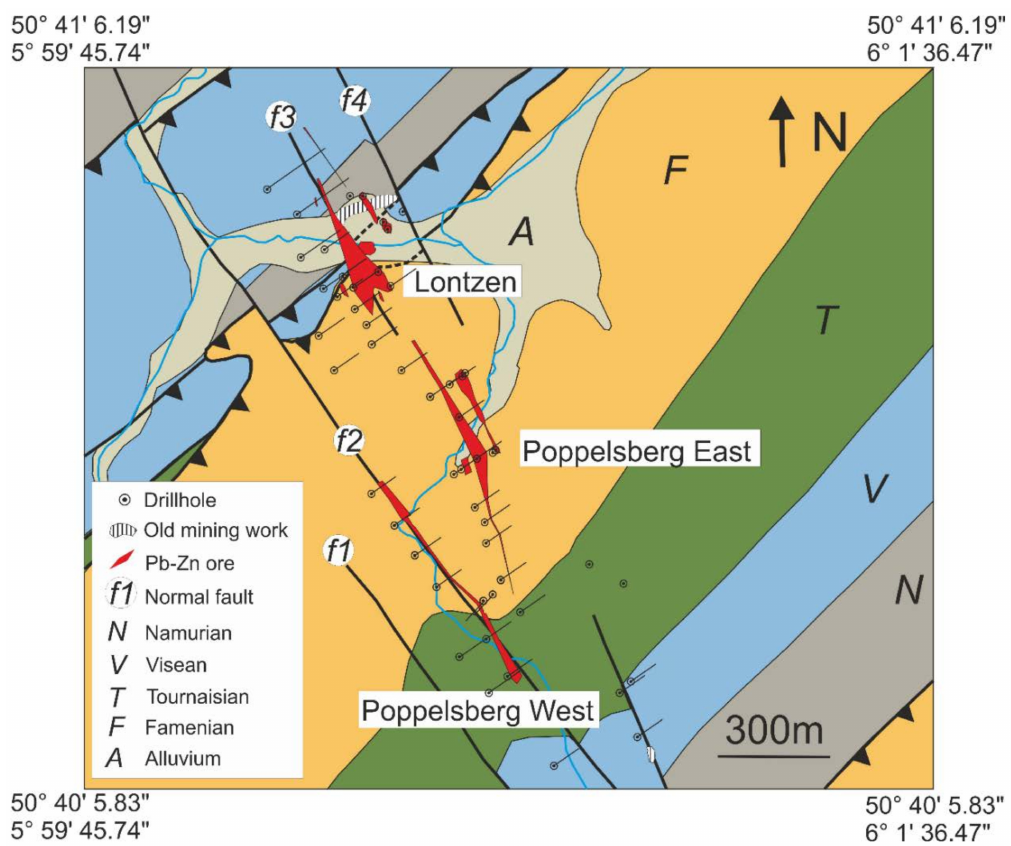
Figure 3. Geology of the Lontzen–Poppelsberg ore deposit showing projection of the drillhole and modelling of the deposit (geological map modified from Laloux et al.